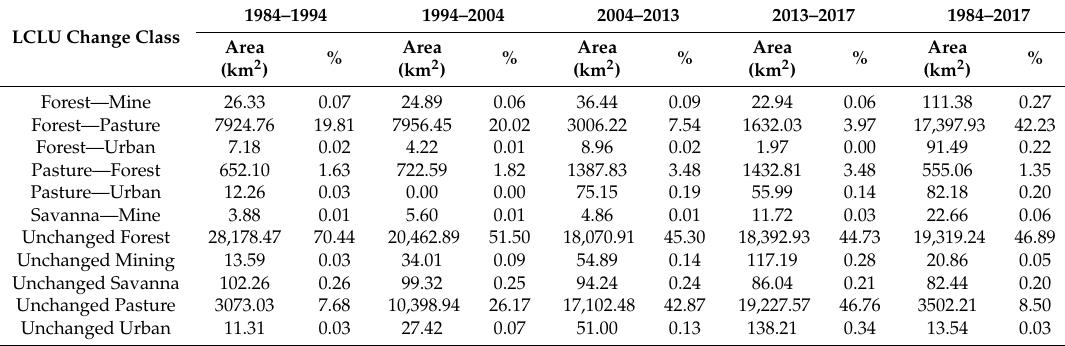
Table 2. Summary of LCLU class change trajectories from the object-based approach between